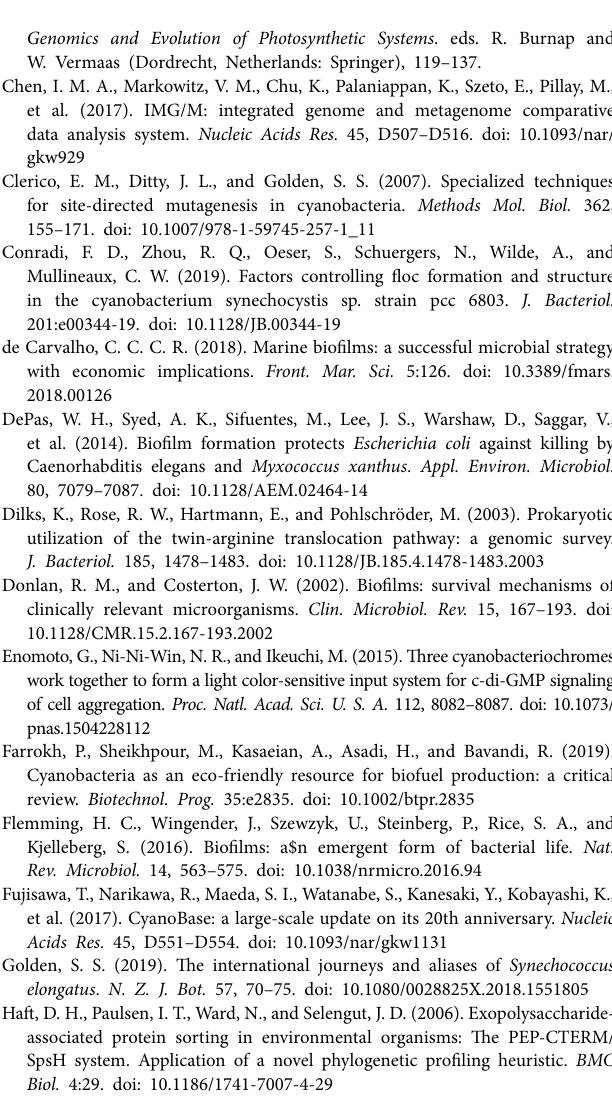
Figure 3H , (10) comparison of all experiment 2 test tube samples, (11) comparison of all BG-11 biofilm samples, (12) comparison of experiment 2 flask samples, data used to produce Figure 4F , (13) comparison of all test tube samples, data used to produce Figure 4E , and (14) enrichment analysis data for named hit clusters of interest for all gene categories listed in Supplementary Table S3